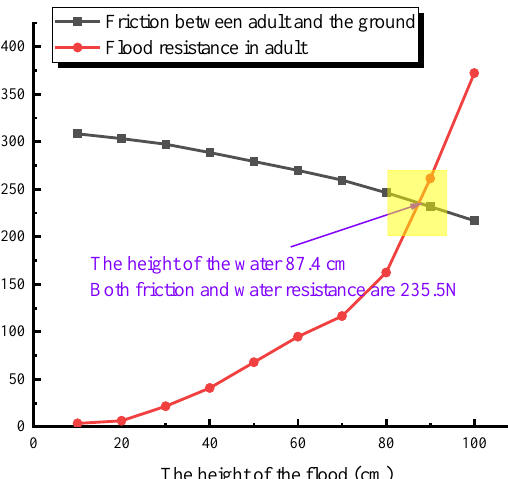
Figure 23. Curve comparison of the flood resistance and friction (child).